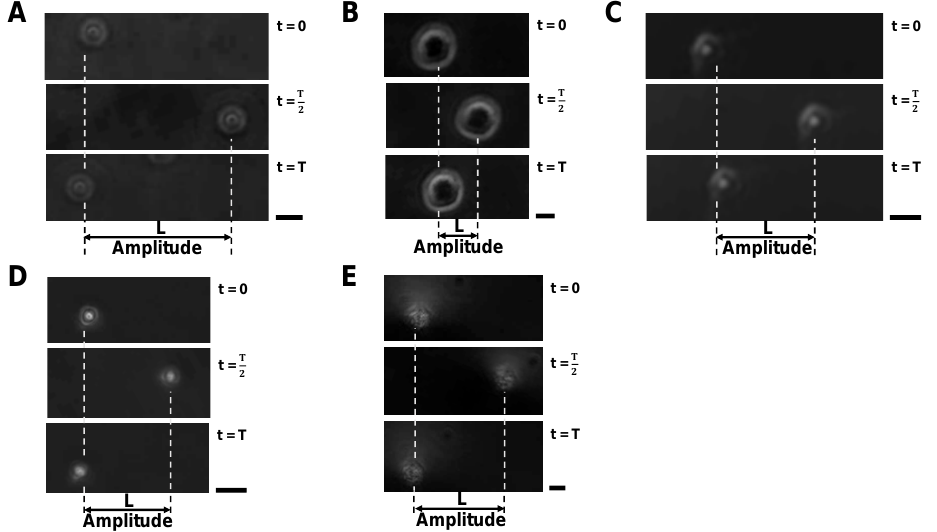
Figure 8. Oscillation amplitudes of samples in 12.5v pp /cm , 0.5 Hz AC electric field. ( A ): 10µm polystyrene microbead, ( B ): HeLa cell, ( C ): Empty alginate microcapsule, ( D ): 10µm polystyrene microbead-encapsulated alginate microcapsule, ( E ): HeLa cell-encapsuled alginate microcapsule. All the experiments were performed in 5% glucose solution. Bars,